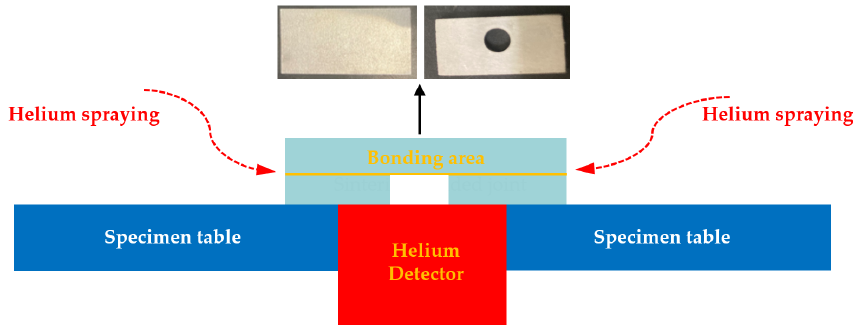
Figure 3. Schematic of gas tightness test for CAB 3003 aluminum joint.